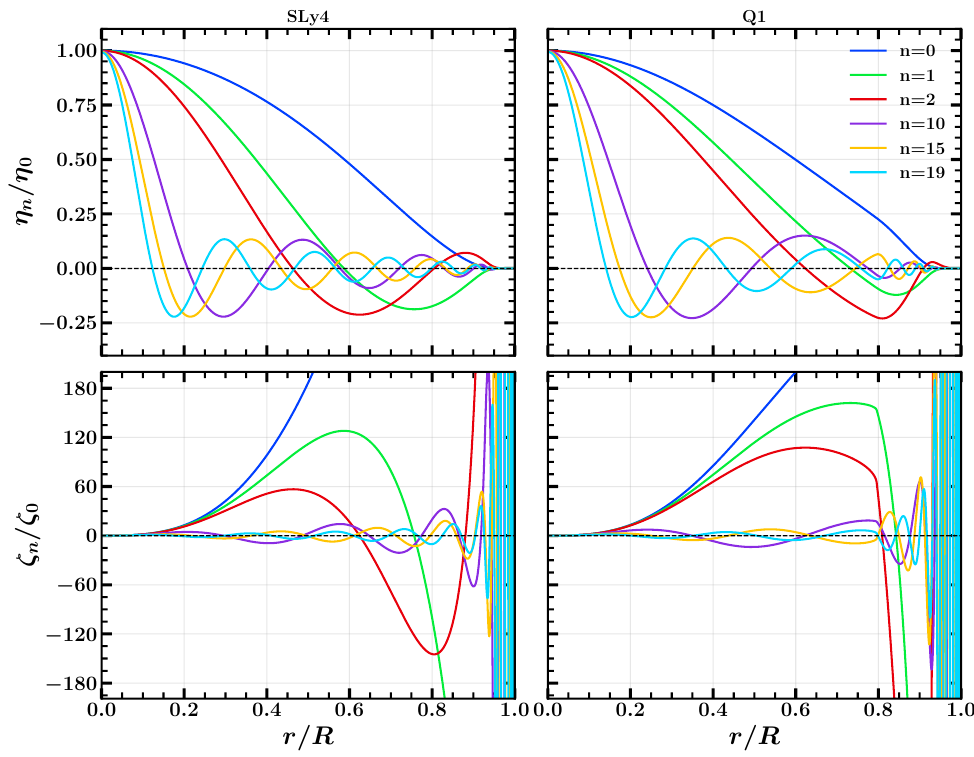
Figure 3. ( Top ): η / η 0 as a function of dimensionless radial coordinate r / R for low ( n = 0,1,2) and highly excited modes ( n = 10,15,19). ( Bottom ): Same as before but for ζ / ζ 0 . In both panels, the left corresponds to an NS with SLy4 EoS, and the right corresponds to that with Q1 EoS at 1.4 M (cid:12) . η 0 and ζ 0 are the values of the respective functions at the smallest radial coordinate r min .